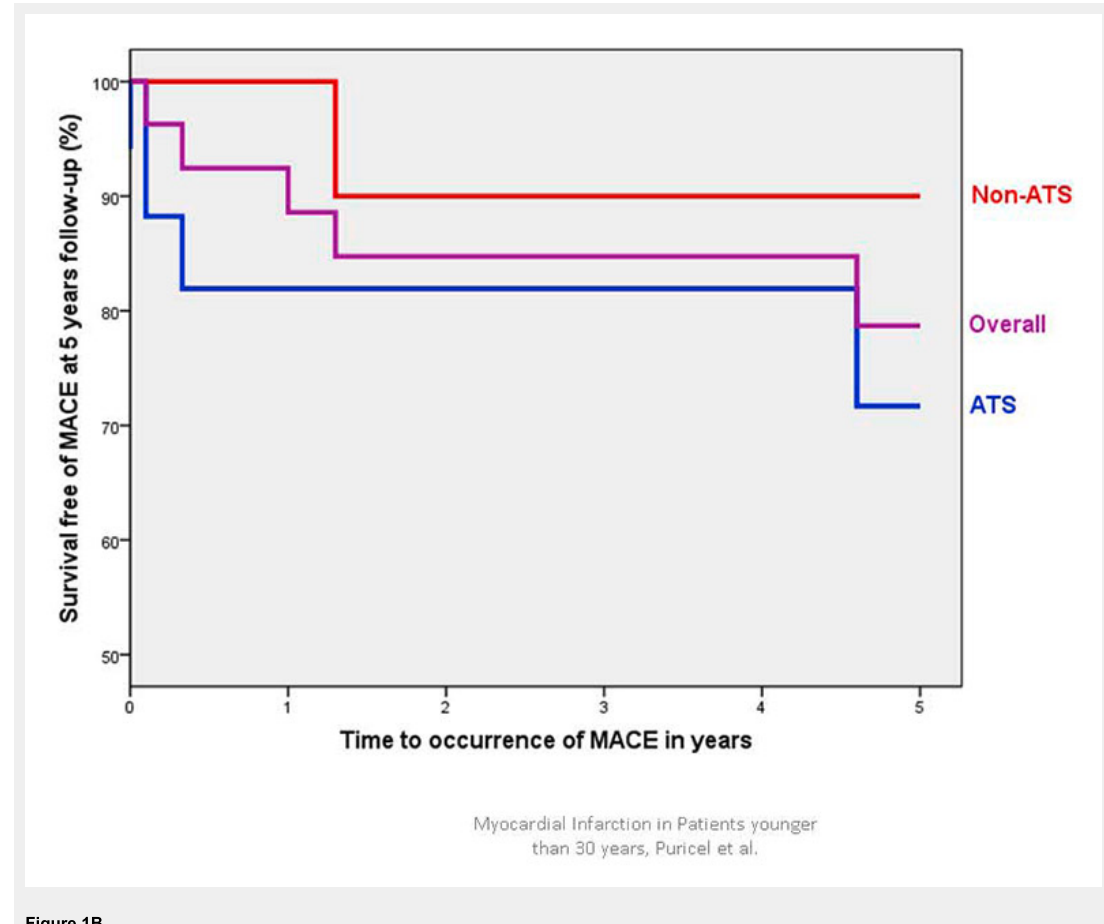
Figure 1B Cumulative survival free of major cardiac adverse events (MACE) in patients <30 years presenting with acute coronary syndrome. ATS = atherosclerosis; non-ATS = patients without angiographic evidence of